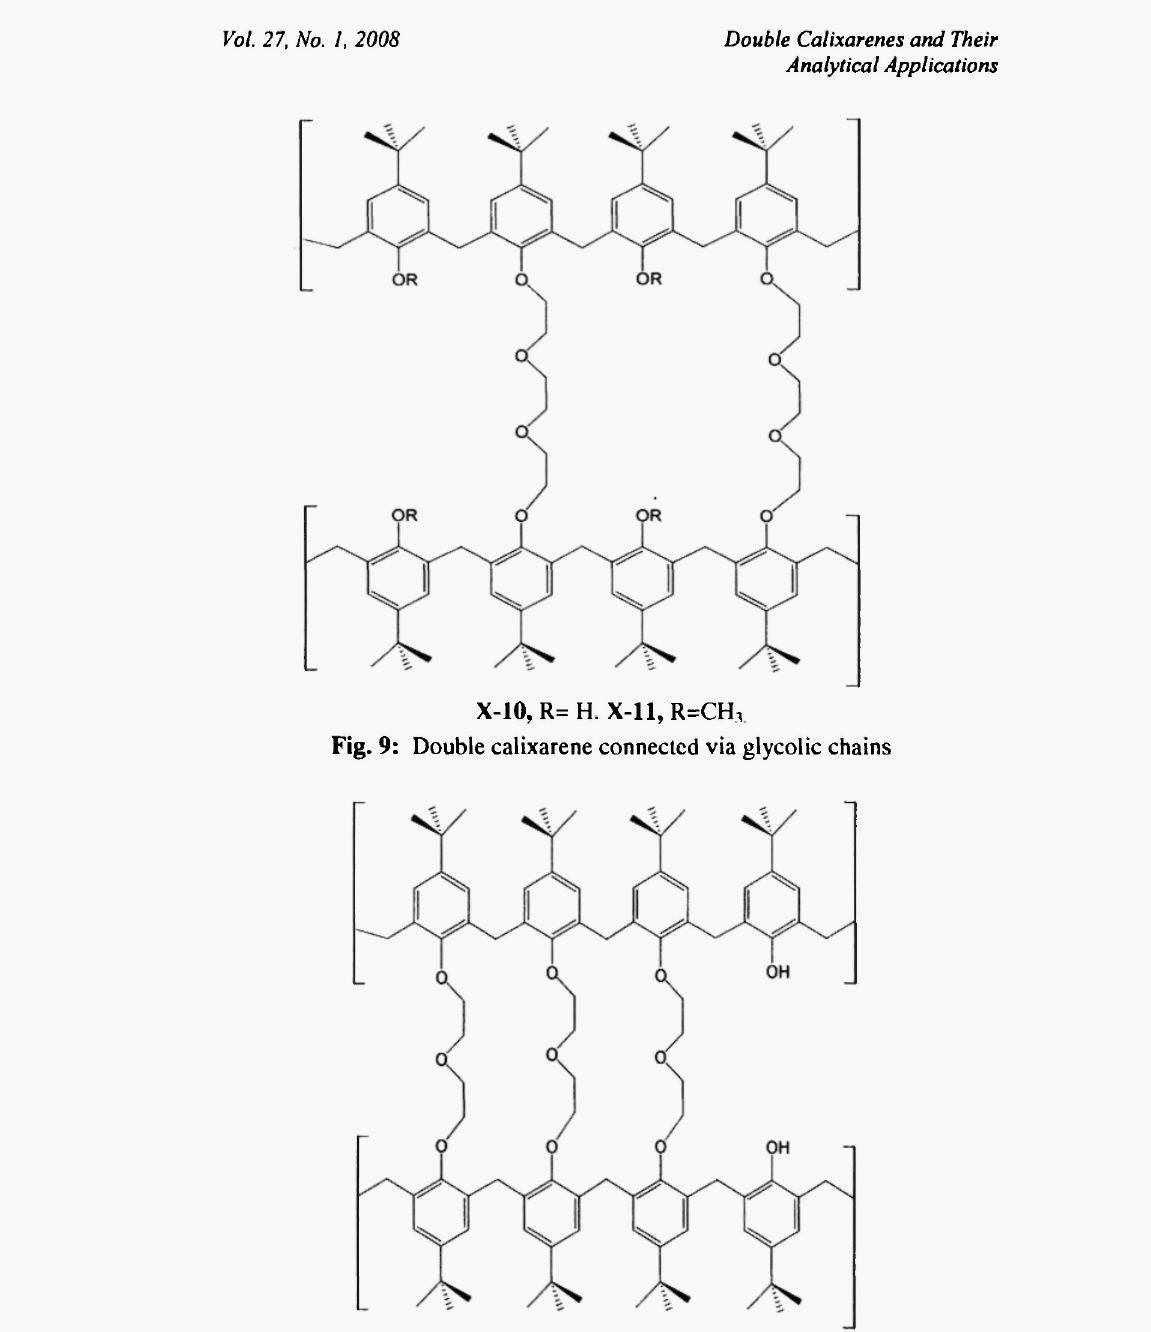
Fig. 10: Double calixarene connected via diethylene glycolic